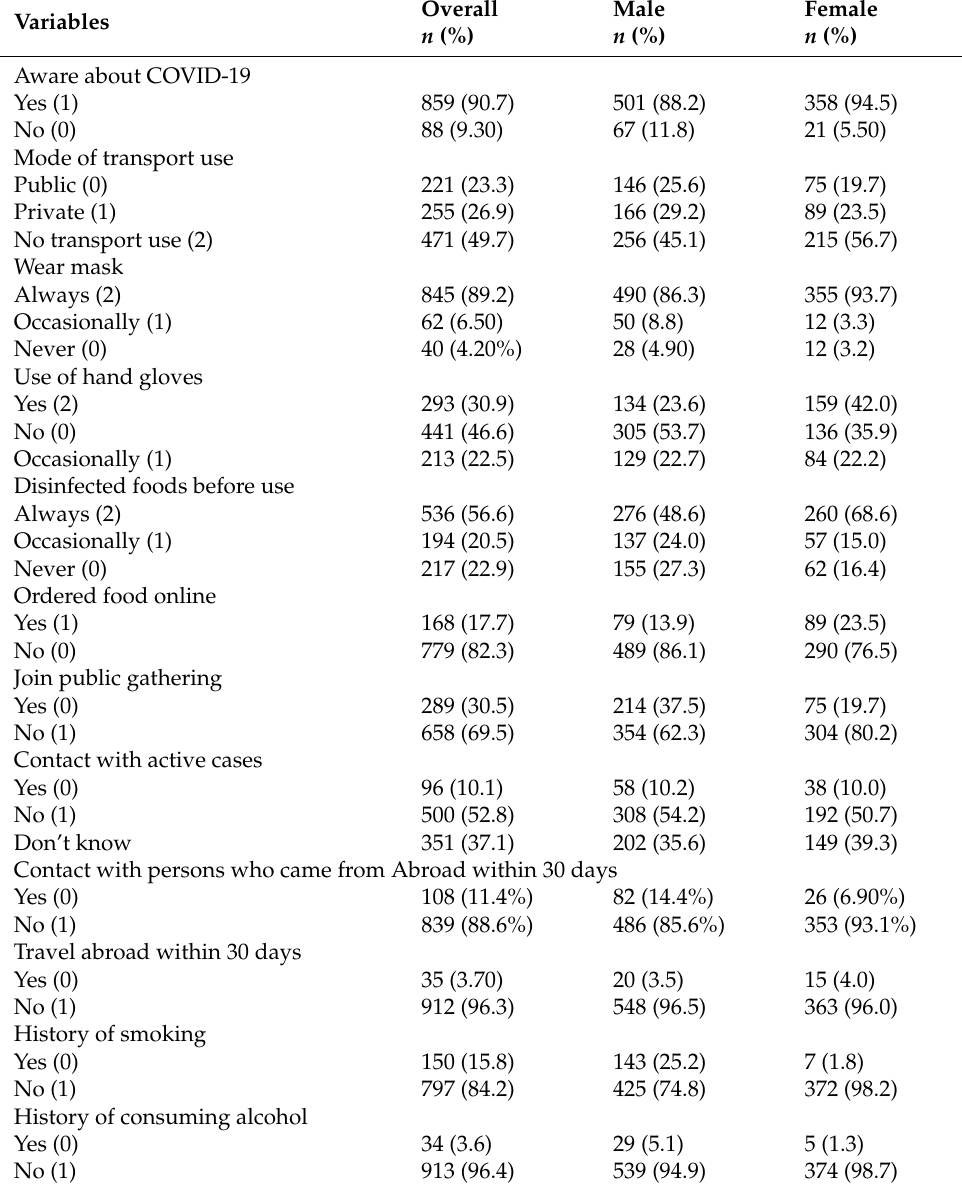
Table 3. Health-seeking behavior of the study